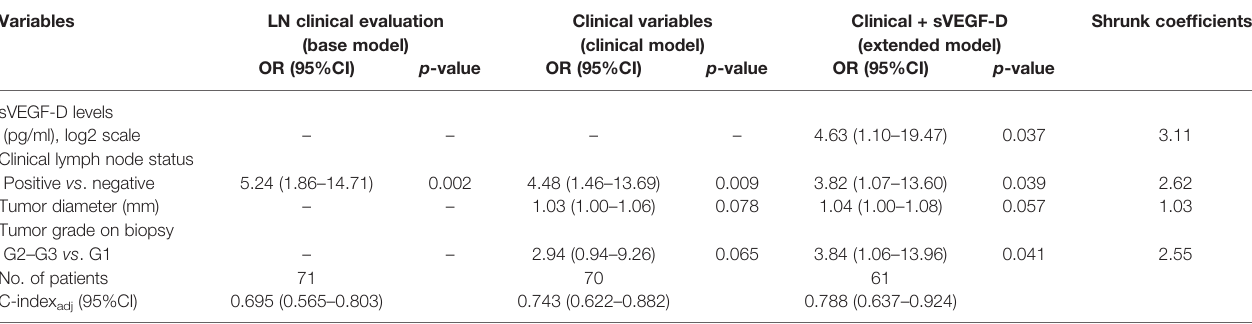
TABLE 4 | Logistic regression model estimates for association with prediction of lymph node in cohort A. Variables